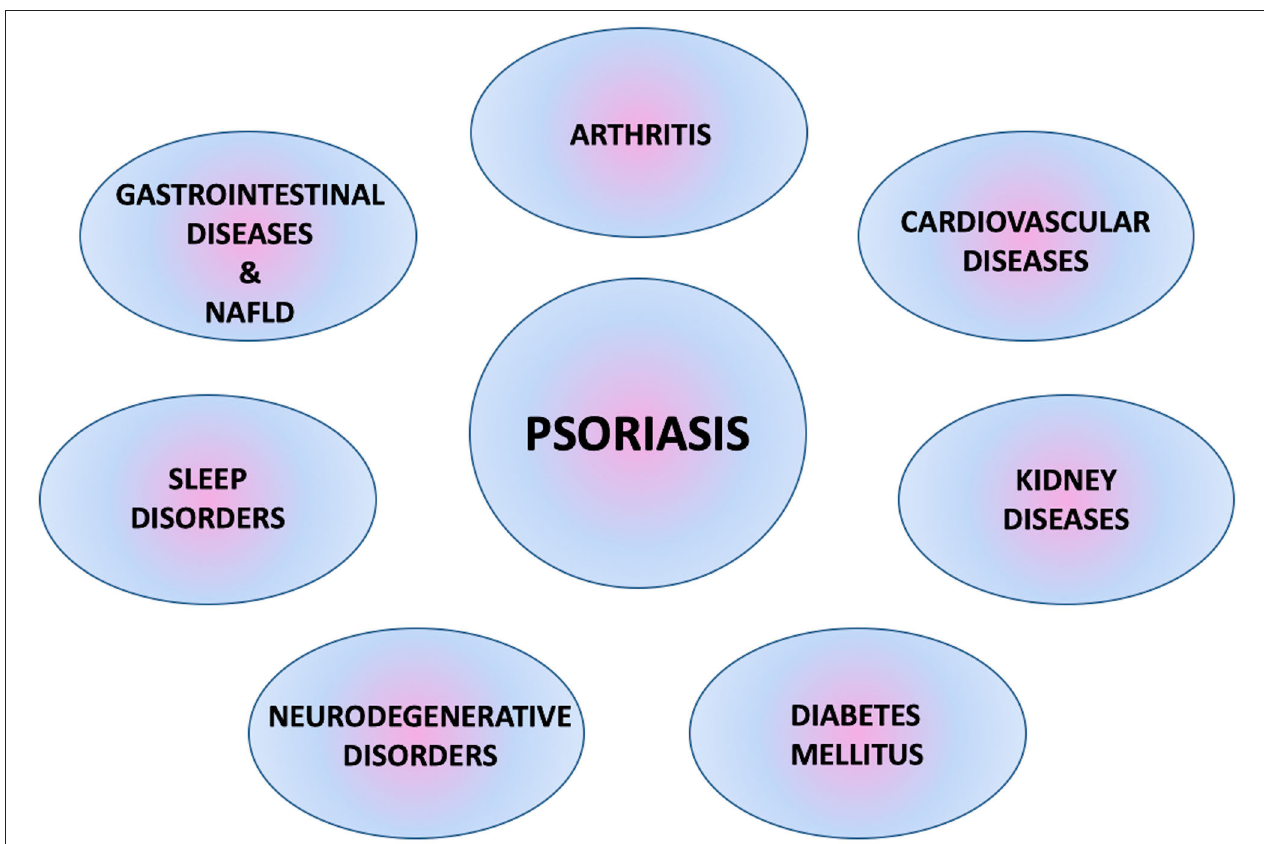
FIGURE 1 | Multiple comorbidities associated with